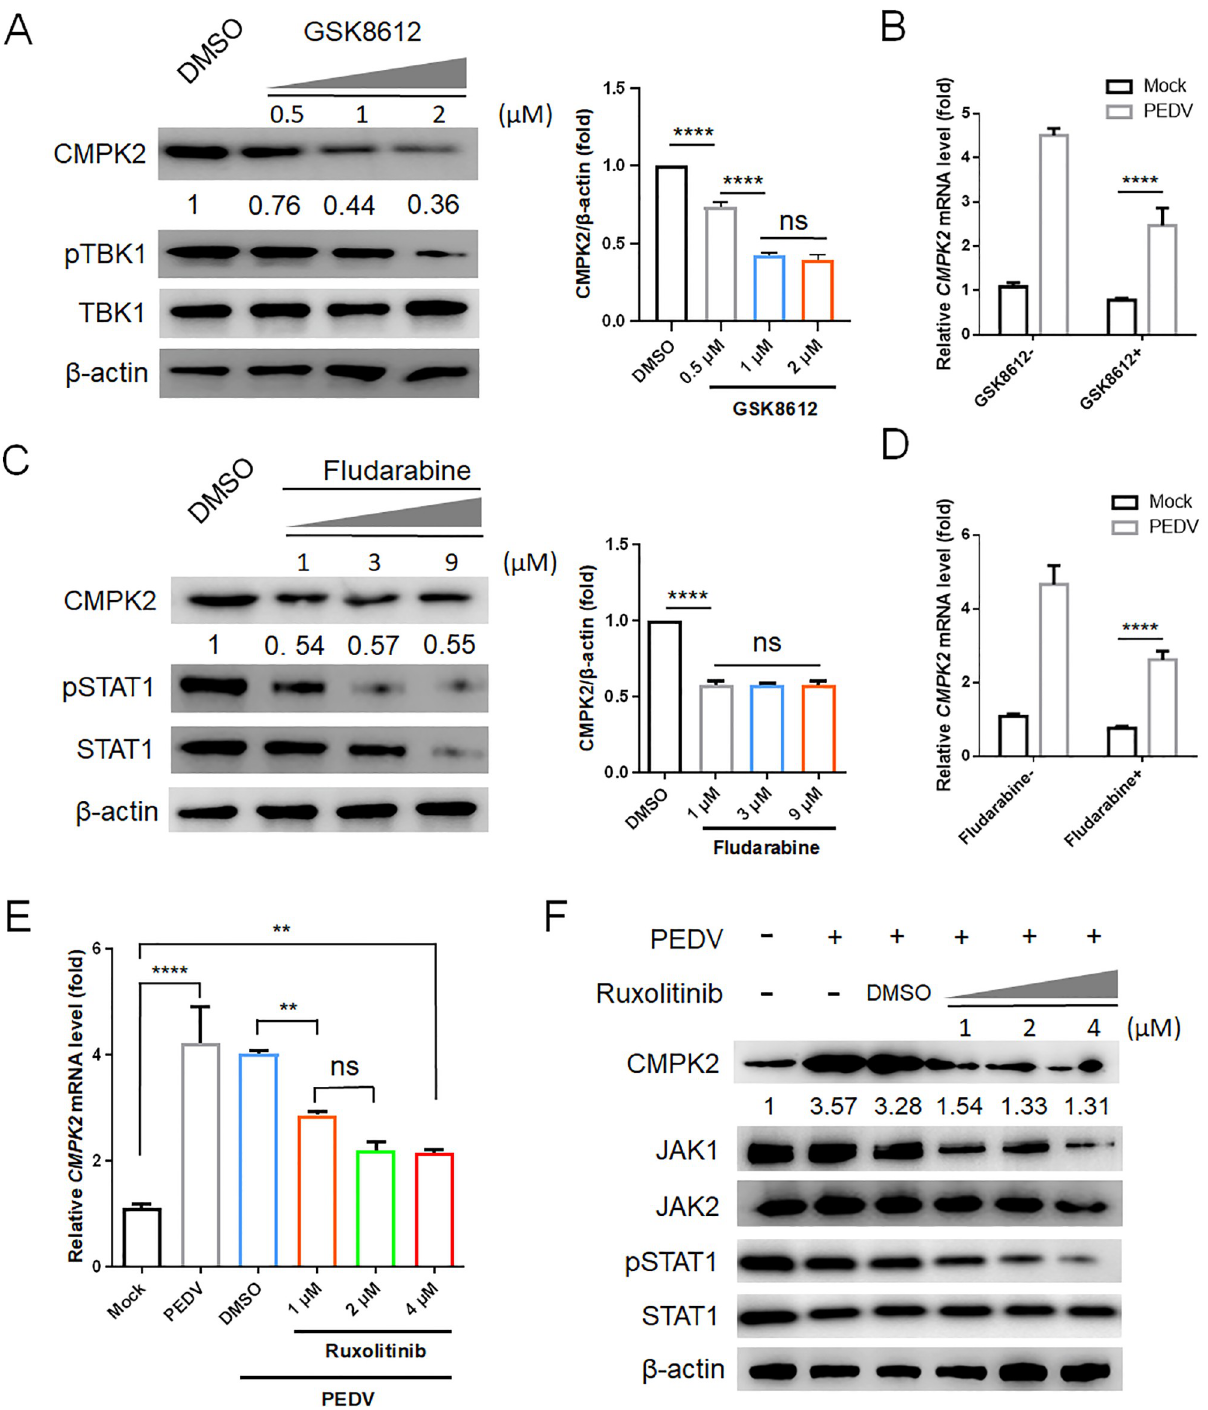
Fig 2. PEDV-induced CMPK2 expression is partially independent of the IFN-I pathway. (A and C) IPEC-J2 cells were treated with DMSO or different concentrations of GSK8612 ( A ) or Fludarabine ( C ) as indicated. The expression of CMPK2 were detected by western blot (left). Quantitative comparisons of the indicated protein levels were analyzed by gray intensity scanning of blots (right). (B and D) qRT-PCR analysis of CMPK2 mRNA levels in IPEC-J2 cells infected with PEDV (MOI = 1) followed by treatment with GSK8612 ( B , 2 μ M) or Fludarabine ( D , 7 μ M). (E and F) IPEC-J2 cells were treated with DMSO or different concentrations of Ruxolitinib as indicated. The expression of CMPK2 were detected by qRT-PCR ( E ) and western blot ( F ), respectively. Data are means ± SD of triplicate samples; statistical analysis was conducted using one-way ANOVA followed by Dunnett’s multiple comparison test or two-way ANOVA followed by Tukey’s multiple comparison test; only the p -value for the most relevant comparisons are